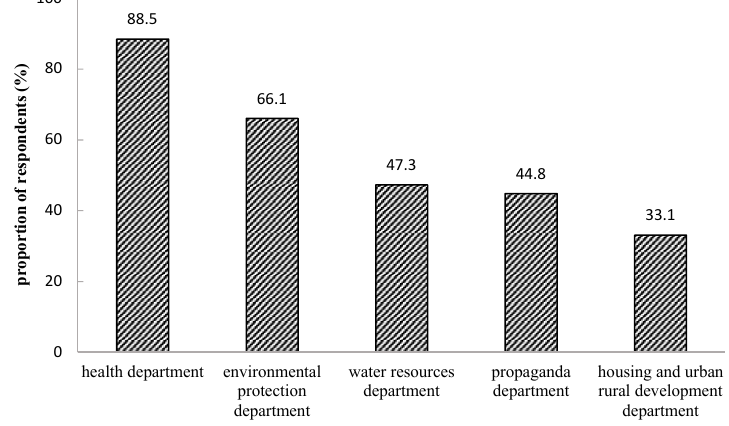
Figure 4. Emergency response provider during drinking water contamination accidents. Note: the same respondent ticked more than one alternative.